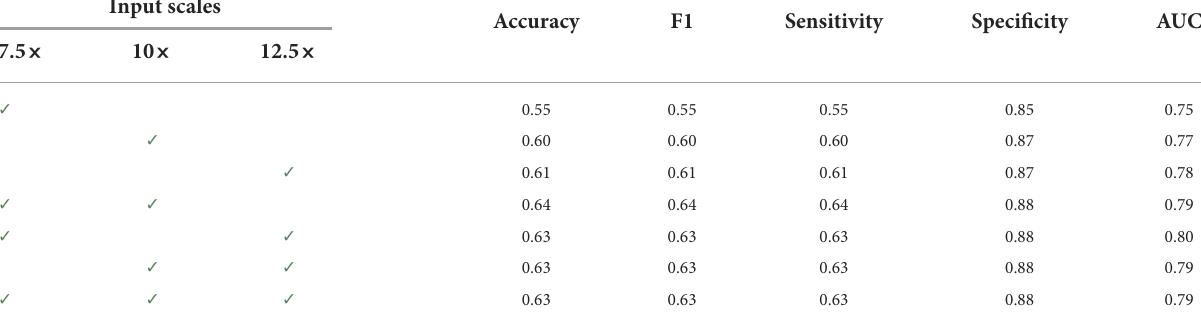
TABLE 4 Overall performance of ScAtNet (This table was published in Wu, W., Mehta, S., Nofallah, S., Knezevich, S., May, C. J., Chang, O. H., Elmore, J. G., Shapiro, L. G. (2021), “Scale-aware transformers for diagnosing melanocytic lesions,” IEEE Access 9, 163526–163541, under a Creative Commons